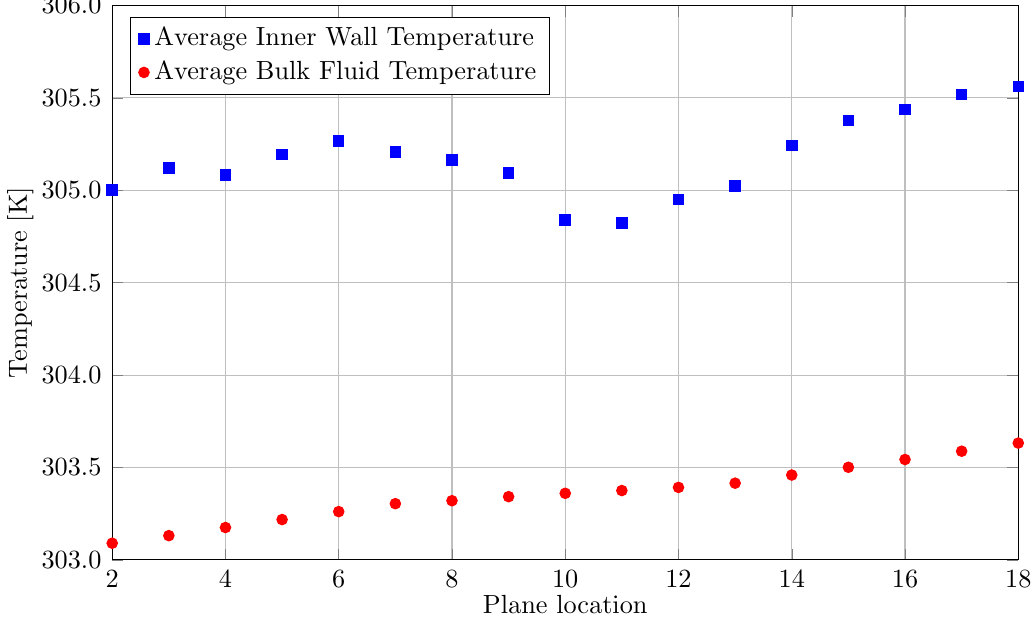
Figure 9. Wall and bulk fluid temperature at each plane location using water at Grid 2.